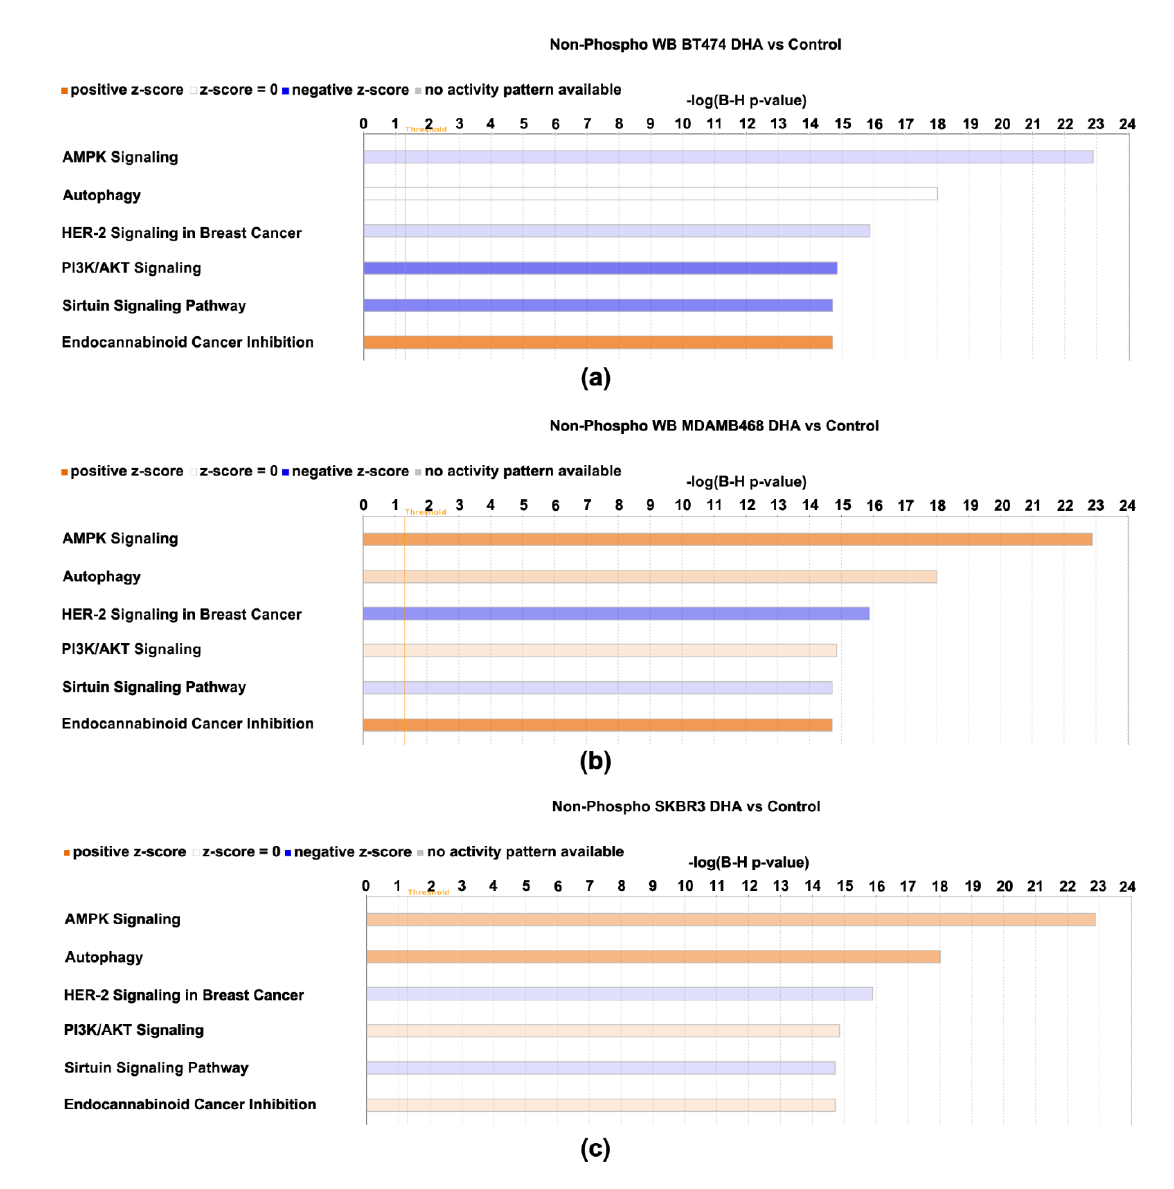
Figure 7. Canonical pathways affected by 4-oxo-DHA across three molecular subtypes of breast cancer cell lines. Canonical pathways affected by 4-oxo-DHA as predicted by the nonphosphory- lated proteome data sets listed in Tables 1 – 4. Canonical pathways shown for cell line ( a ) BT474, ( b ) MDAMB468, and ( c ) SKBR3.The − log(B-H p -values) is the multicomparison adjusted probability that the association between the protein expression set and the canonical pathway is due to chance.